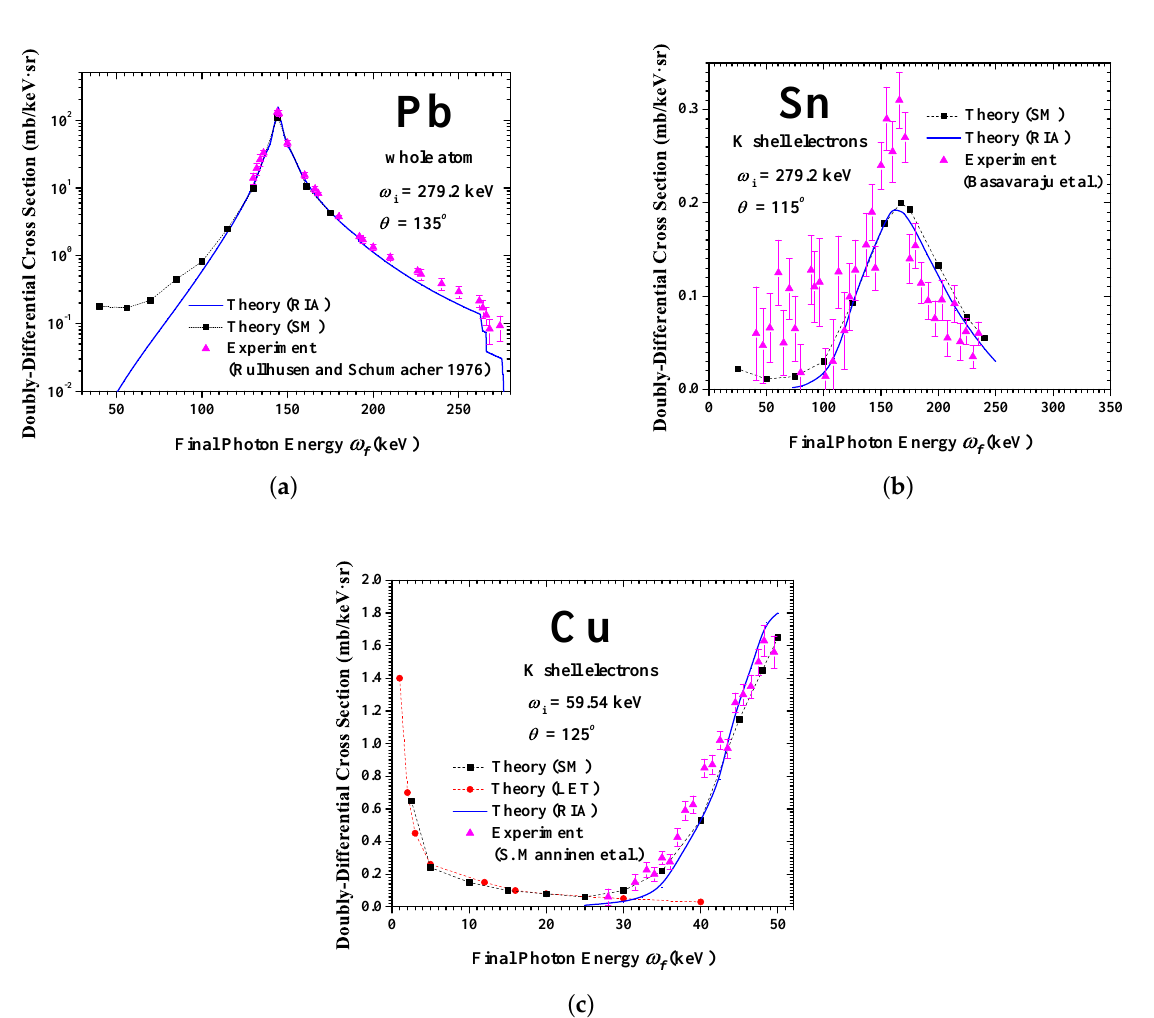
Figure 5. DDCS of Compton scattering for Cu and Pb elements. In this figure, the vertical axis labels the DDCS d σ / d Ω f d ω f , and the horizontal axis labels the final photon energy ω f . The subfigures ( a – c ) correspond to the following cases: ( a ). Compton scattering for Pb atom at ω i = 279.2 keV and θ = 135 ◦ ; ( b ). Compton scattering for K-shell electrons of Sn atom at ω i = 279.2 keV and θ = 115 ◦ ; ( c ). Compton scattering for K-shell electrons of Cu atom at ω i = 59.5 keV and θ = 125 ◦ . The experimental measurements are given by references [83–85]. The theoretical predictions from RIA and SM approaches are given by Qiao et al. and Bergstrom et al.